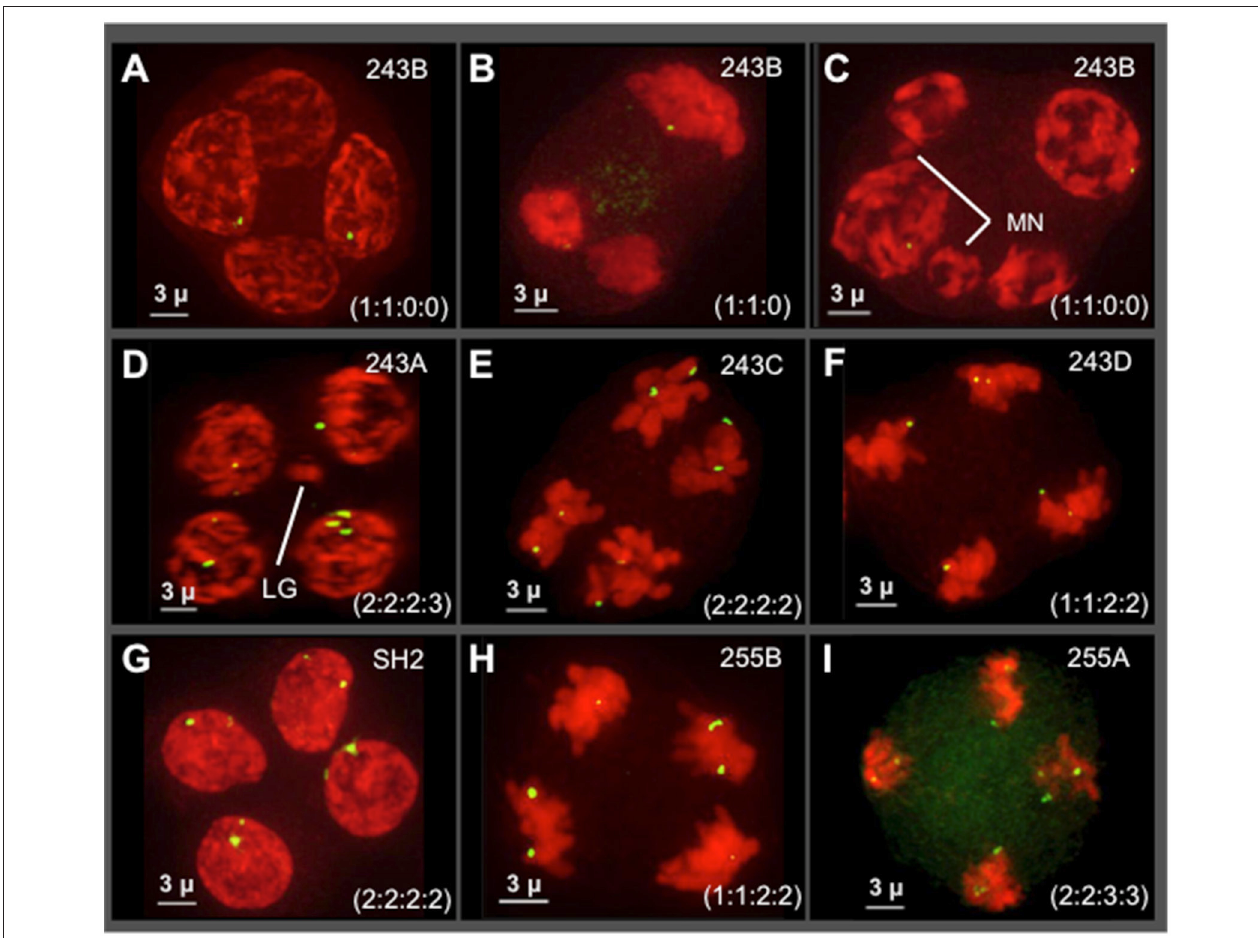
FIGURE 6 | Survey of 5S rDNA FISH in tetrads (meiosis II) of seven different plants. Projections of 3D FISH datasets were produced as described in Figure 1 but with DAPI shown in red and 5S rDNA FISH, green. Hop tetrads are highly variable. (A–F) Four progeny of cross 243, in the Cascade family. (A–C) A single progeny of cross 243 from the plant designated 243B. (D) Plant 243A. (E) Plant 243C. (F) Plant 243D. (G) Plant SH2, a wild collected var. neomexicanus hop. (H–I) Two progeny of cross 255 from the Apollo family. (H) Plant 255B. (I) Plant 255A. The 5S rDNA ratios for each tetrad are listed in each panel. The occurrence of micronuclei (MN) and chromosome laggards (LG) are indicated in some of the panels. The length of the scale bars (3 microns) is indicated.